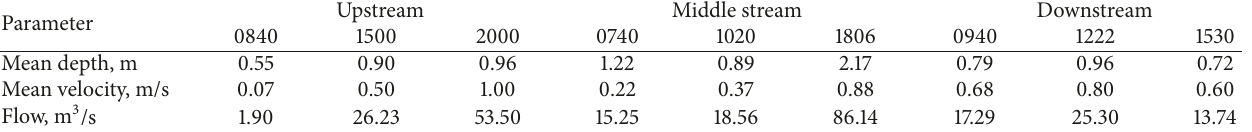
Table 1: Hydrological characteristics in the three segments of Batang Ai below the dam.